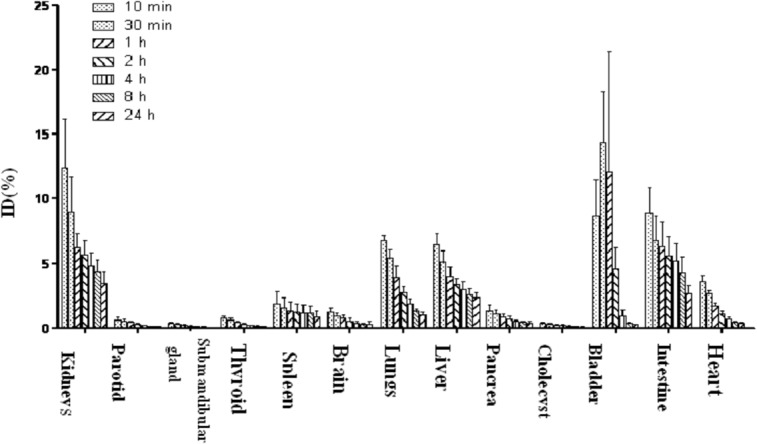
The quantified analysis of 99mTc-RGD-BBN in major organs of healthy volunteers calculated from the whole-body images obtained at 10 min, 30 min, 1 h, 2 h, 4 h, 8 h and 24 h after administration.